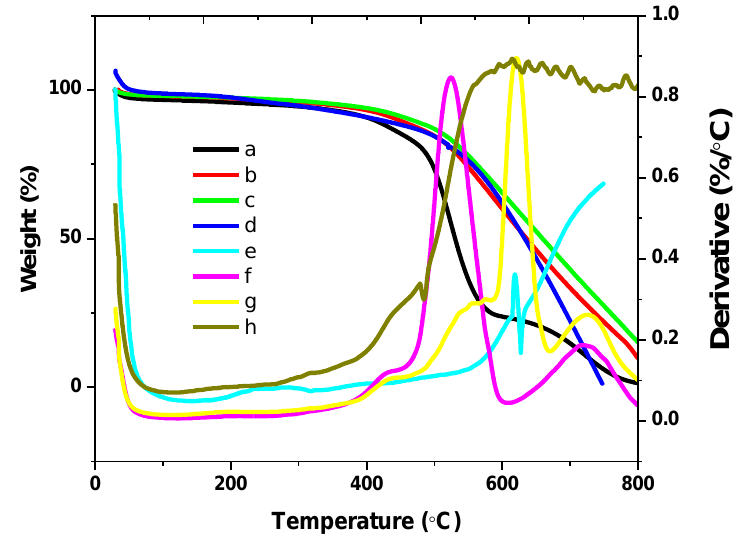
Figure 5. The hybrids temperature analysis: ( a – d ) percentage weight curve of HGPPy.CB 20% 1:3, HGPPy.CB 20% 3:7, HGPPy.CB 20% 7:13, PPy.CB 20% and ( e – h ) derivatives curve of PPy.CB 20% , HGPPy.CB 20% 1:3, HGPPy.CB 20% 3:7 , HGPPy.CB 20% 7:13.